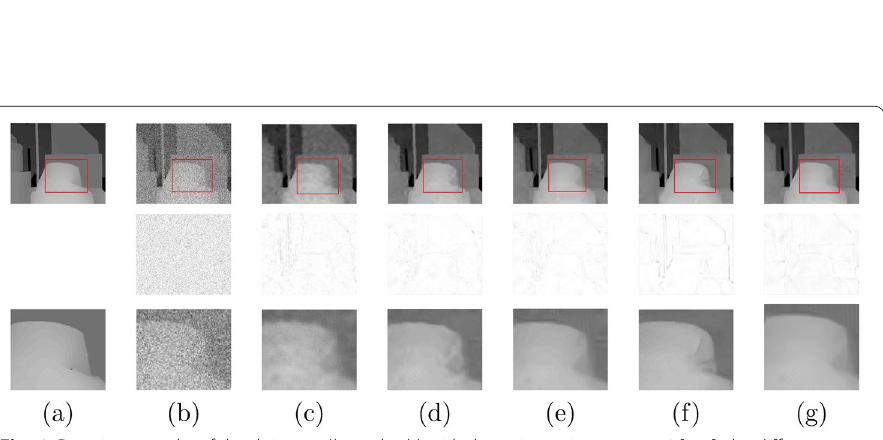
Fig. 6 Denoising results of depth image ( lampshade ) with the noise variance σ = 50 [top], the difference between the original depth images and the filtered images [middle], and zoom-in image [bottom]. From the left ( a ) to right ( g ) are: the original image, the noisy image, the results obtained by NLM, BM3D, OGLR, ADnet and the proposed method